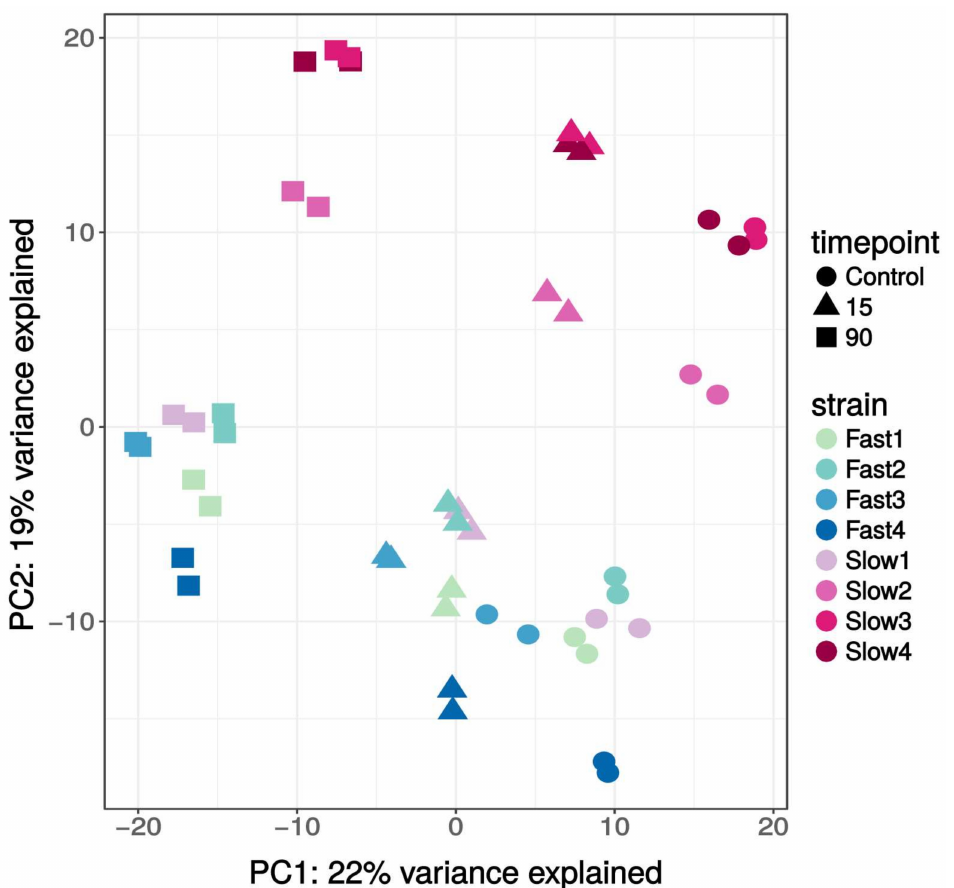
Figure 2. Principal component analysis (PCA) based on the 500 most variable genes. See Additional File 6 (Figure S3) for PCA plots with 250 genes and all of the genes in the dataset. Cold-tolerant strains (fast CCR) are shown in shades of blue; cold-sensitive strains (slow CCR) are shown in shades of